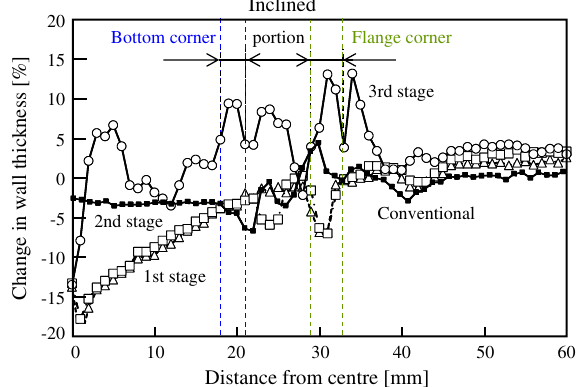
Figure 5. Distribution of change in wall thickness of cup after 3rd stage for s 1 = 22 mm, s 2 = 19 mm and h = 10